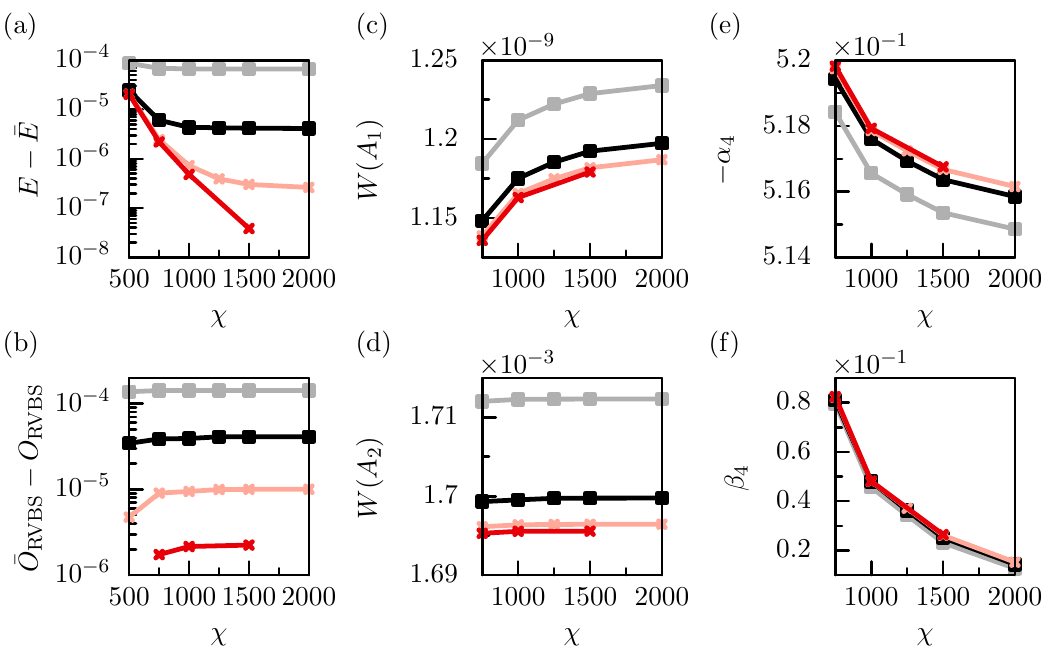
Figure 16: Final state results over MPS bond-dimension χ , from subsequently im- proved energy convergence thresholds ∆ E (grey and black squares: 10 − 6 and 10 − 8 , rose and red crosses: 10 − 10 and 10 − 12 ). Data obtained with an 24 × 8 lattice and λ = 0.3 for (a) Energy and (b) RVBS order, offsetted by extrapolations to χ → ∞ , ∆ E → 0, (c) Wilson loops for rectangles A ∼ 8 × 4 and (d) A ∼ 3 × 2, (e) Wilson 1 2 loops fit parameters α and (f) β 4 4